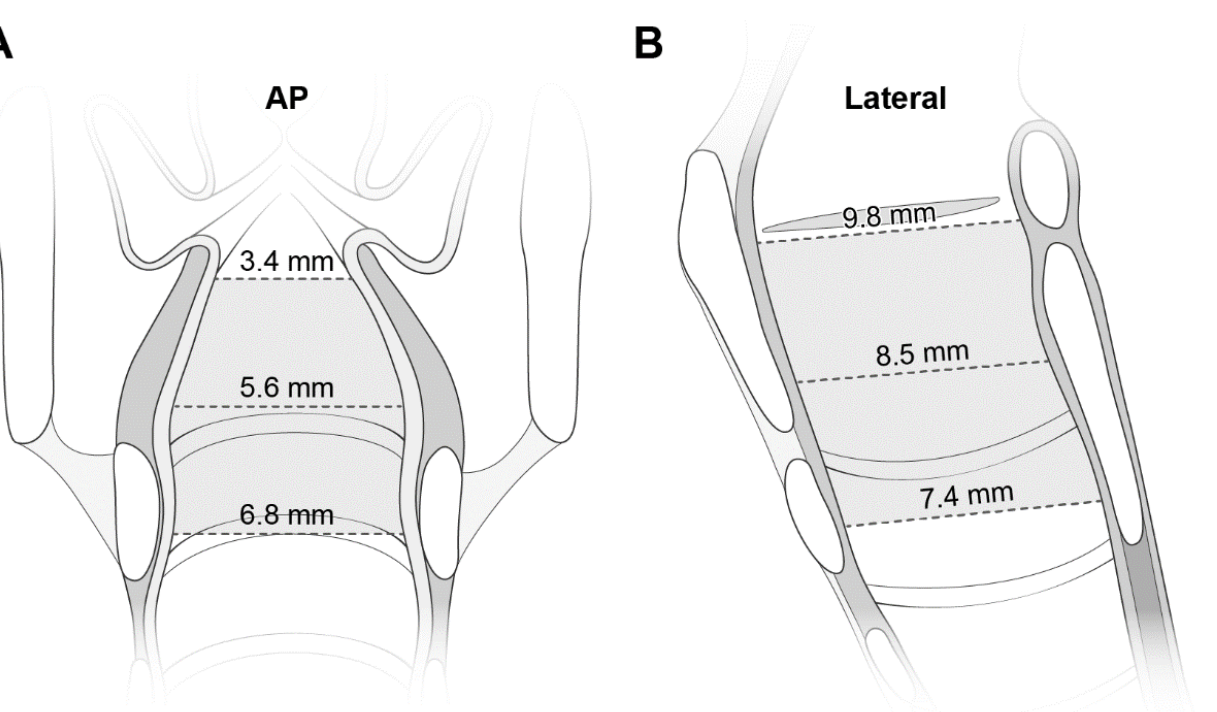
Table 1. Laryngeal dimensions per level (n = 401).